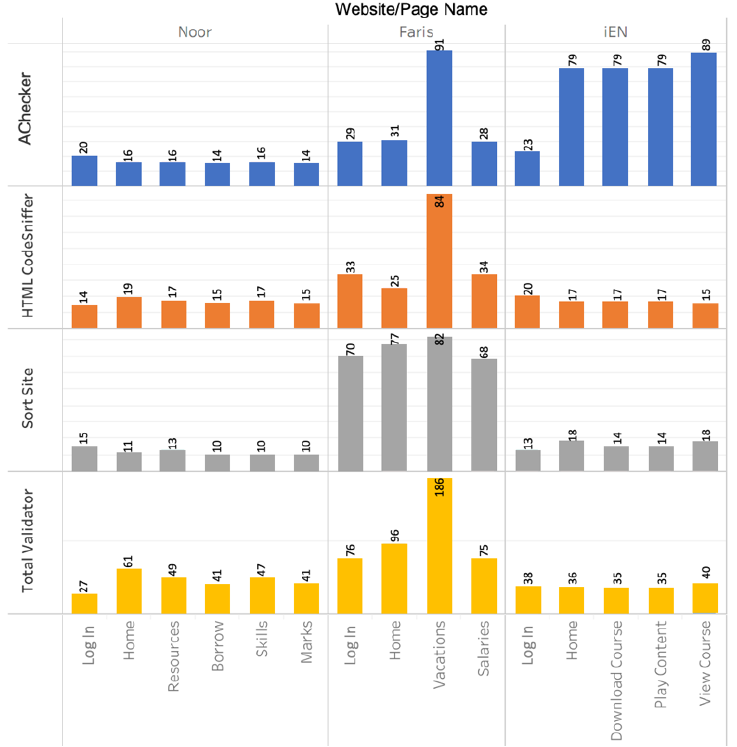
Figure 7. Comparison based on the systems’ performances (number of errors).